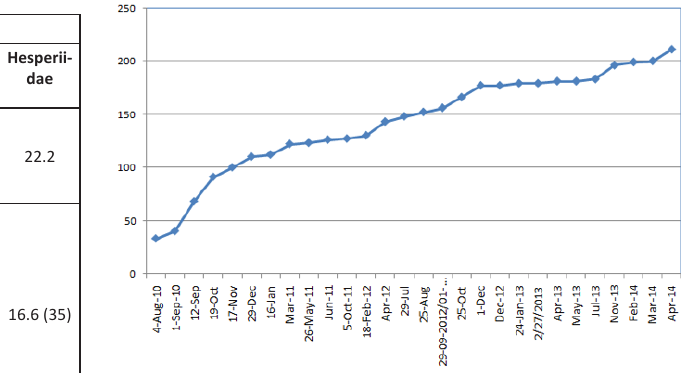
Figure 2. Species accumulation curve for 28 samplings of butterflies through different seasons in Gibbon WS (August 2010–April 2014)